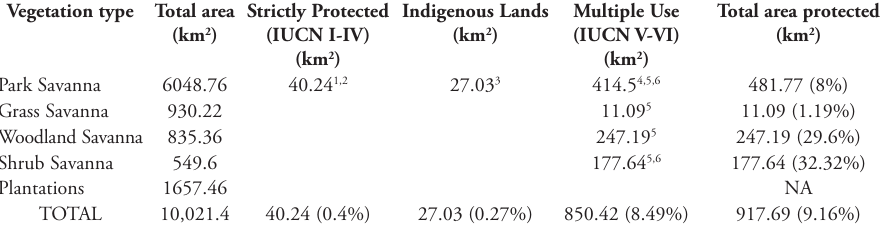
Table 1. Total area and area protected of the four savanna types, and area of exotic plantations. Total area and area protected in each of three protection categories, of each of the four main vegetation types in the Cerrado of Amapá, and the total recorded area of plantations of exotic woody species. All values were calculated in ArcGIS v10.4.1 (ESRI 2011) using the Brazilian Institute of Geography and Statistics’ vegetation cover map for the Amazon (IBGE 2004a), and the shapefiles of Conservation Units and Indig- enous Lands available from the Amapá State Environmental Secretariat (SEMA-AP 2016) and the World Database on Protected Areas (IUCN and UNEP-WCMC